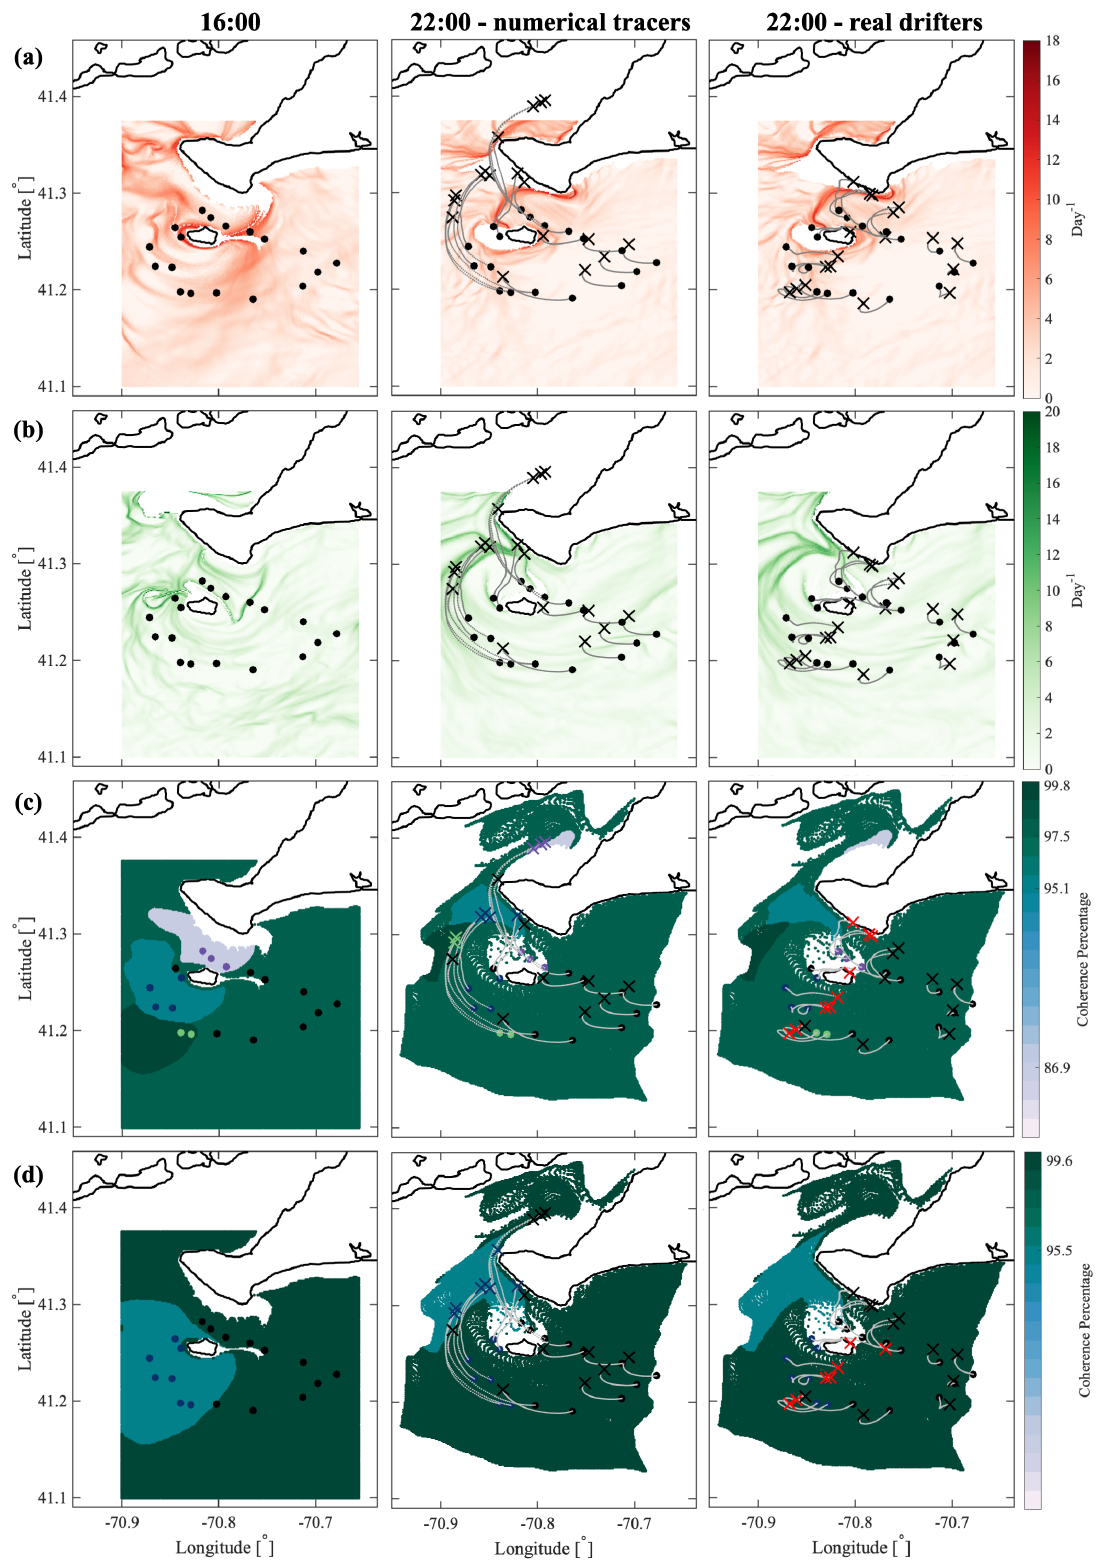
Figure 8. LCS, numerical tracers and experimental drifter positions at the start (16:00 UTC) and end (22:00 UTC) of the 2018 experiment on August 7. ( a ) Forward and ( b ) backward FTLE. ( c , d ) Spectral clusters with coherence metric. The drifters are color-coded according to the cluster to which they belong, with red crosses if their final positions were outside their initial